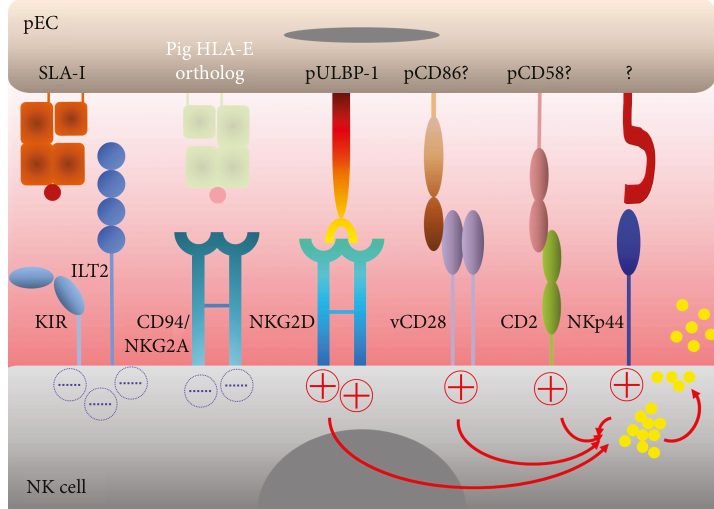
Figure 3: Receptors and ligands involved in pig endothelial cells lysis by human NK cells. There is a tight balance between activating and inhibitory signals that control NK cytotoxicity. The activating NK receptors NKG2D and NKp44 bind to their pig ligands: pULBP-1 and an unidenti fi ed molecule, respectively, and trigger lytic granule release (shown by red arrows and yellow circles). A role of CD2 and variant CD28 in facilitating NK cytotoxicity has been described in NK subpopulations, potentially by interacting with porcine CD58 and CD86, respectively. The inhibitory NK receptors, KIR, ILT2, and CD94/NKG2A, poorly recognize porcine MHC-I molecule (SLA-I) including the pig ortholog for HLA-E leading to a lack of inhibitory signals (in dotted blue) and NK cell